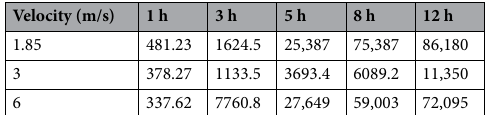
Table 5. The fitting data of polarization resistance in the WM.